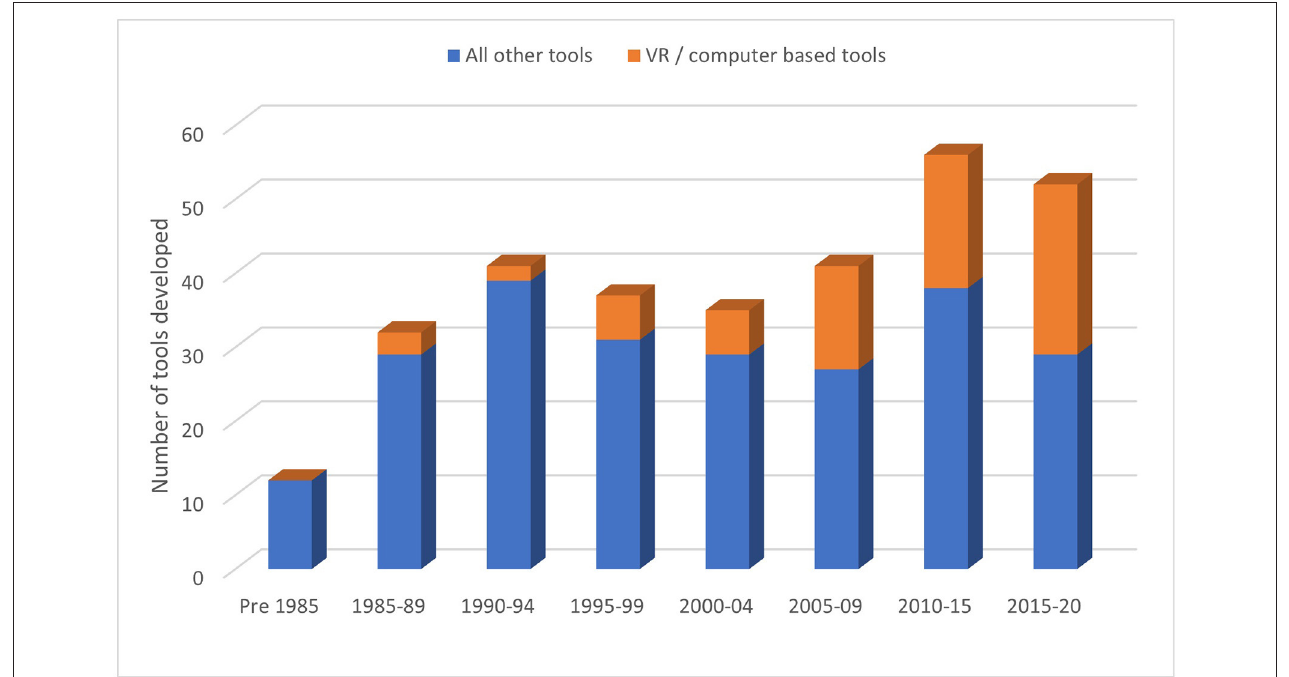
Frontiers in Neurology |